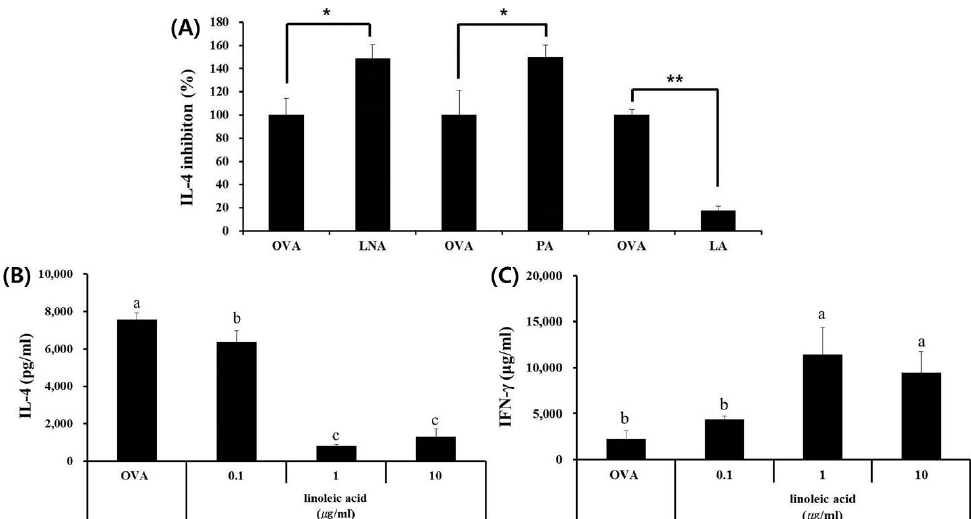
Figure 4. Effects of linoleic acid in skullcap hexane fraction on OVA ‐ induced Th2 immune response